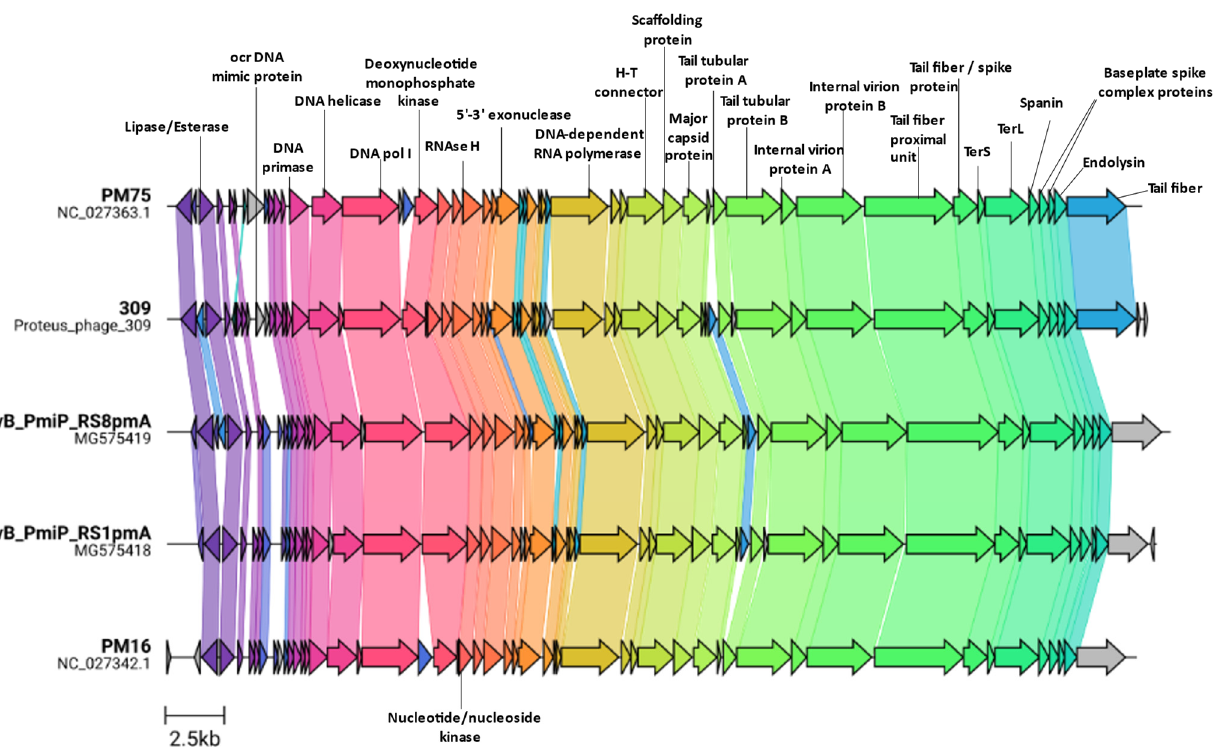
Figure 4. Comparison of Proteus _virus_309 genome with those of closely related viruses. Proteus _virus_309 shares a unique open reading frame (ORF2) with Proteus phage vB_PmiP_RS8pmA, while more distantly related proteins are present in Providencia phage PSTRCR_114 and a range of Krischvirus species (RB49, JSE, Phi1 and ECD7). This ORF is divergently transcribed, and possibly co-regulated, from a putative lipase/esterase present on all Novosibovirus genomes. Proteus _virus_309 encodes a putative Ocr-like DNA mimic protein (ORF9), absent in all other classified Novosibovirus . The T7 Ocr protein protects viral DNA from digestion by host Type I restriction endonuclease by acting as a decoy [56] as well as interacting with the Bacteriophage exclusion (BREX) defense system [57]. The Ocr-like DNA mimic protein may have a similar role. The absence of this protein in other members of Novosibovirus suggests that those hosts do not target the phage DNA for degradation in the same way as for Proteus _virus_309 and its host P. mirabilis B16. The genomic region occupied by Ocr on the Proteus _virus_309 genome is occupied by a DNA adenine methylase (DAM) on Proteus phage PM75. These enzymes are multifunctional and could protect phage DNA from restriction endonucleases, play a role in promoter regulation or efficient release of progeny [58]. Modification of the genome at this position along with sharing a specific tail fiber protein with PM75 may partly explain the much larger burst size of PM16 compared with Proteus _virus_309 and PM75 [44]. This specific tail fiber protein (ORF57), shared only between PM75 and Proteus _virus_309 and no other known Proteus phages, may also explain the narrow spectrum host specificity of these two phages. In the other three Novosibovirus genomes, a conserved hypothetical protein is present at this location. For obligately lytic T-even phages, both the length of the latent period and the burst size increase if more phages adsorb to the cell when infected, termed lysis inhibition [59,60]. The latent period for PM16 was determined to be approximately 15 min,